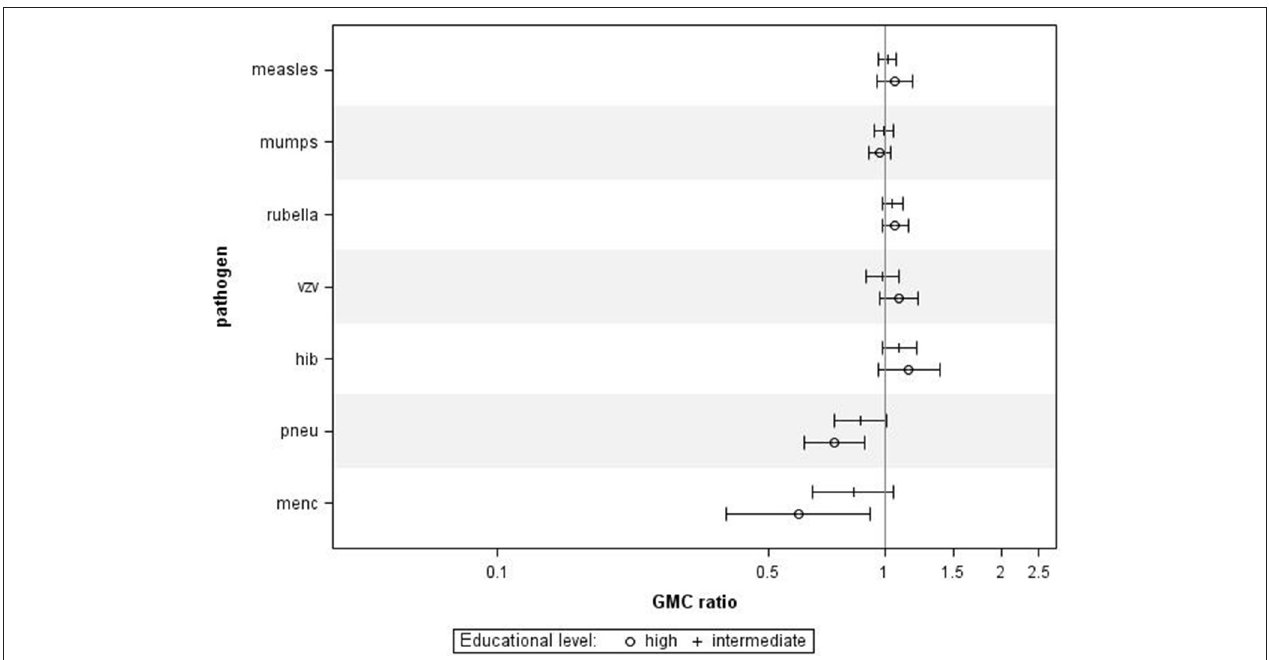
FIGURE 4 | Validation in Pienter 1. Crude geometric mean concentration ratios per pathogen of high and intermediate educational level vs. low educational level with corresponding 95% C.I. N (measles, mumps, rubella) = 3,575, N (varicella) = 629, N (HiB) = 3,571, N (pneumo) = 723, N (MenC) =